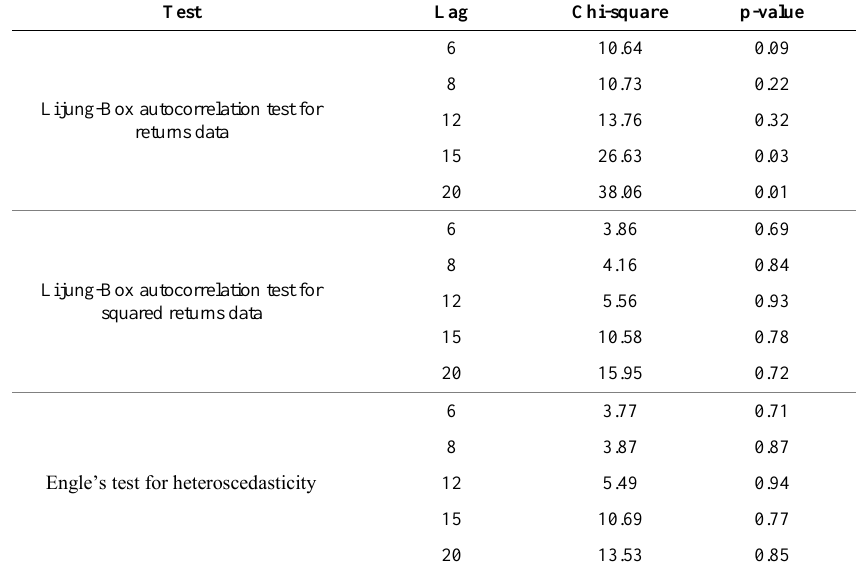
Table A-2. Results of the Lijung-Box test for autocorrelation and the Engle ARCH test for heteroscedasticity at